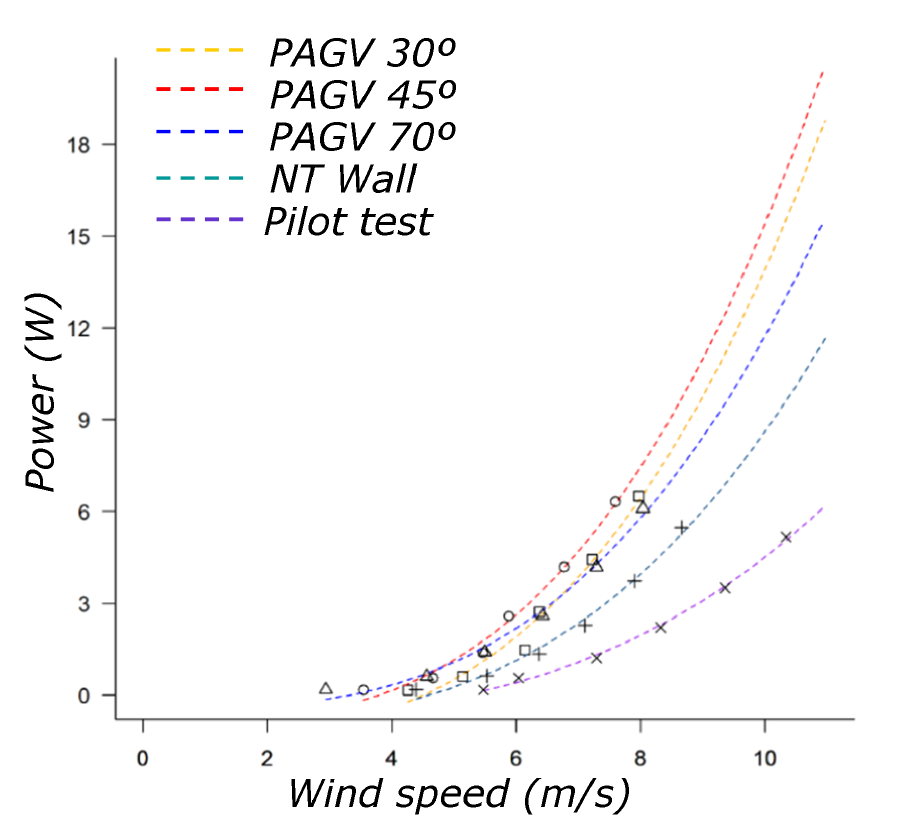
Figure 8. Power production versus wind speed for different positions of the vane and the pilot test without the